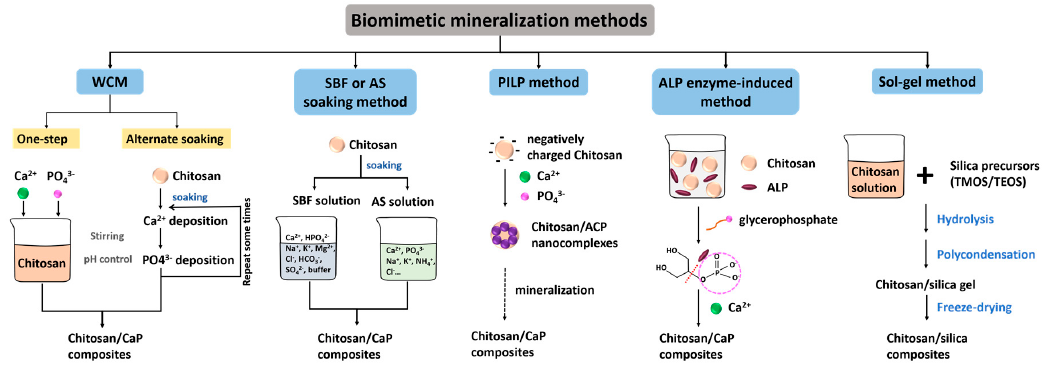
Figure 1. Biomimetic mineralization methods for the fabrication of chitosan-based mineralized composites.